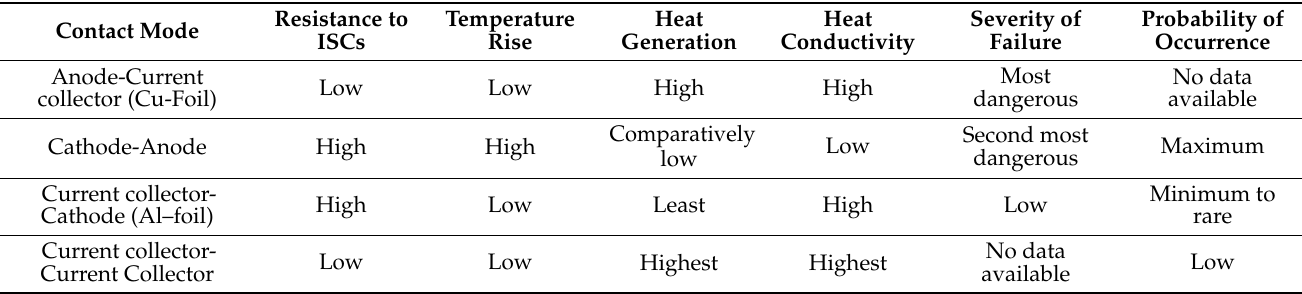
Table 1. Modes of contact and its effects (based on the data from [140]).